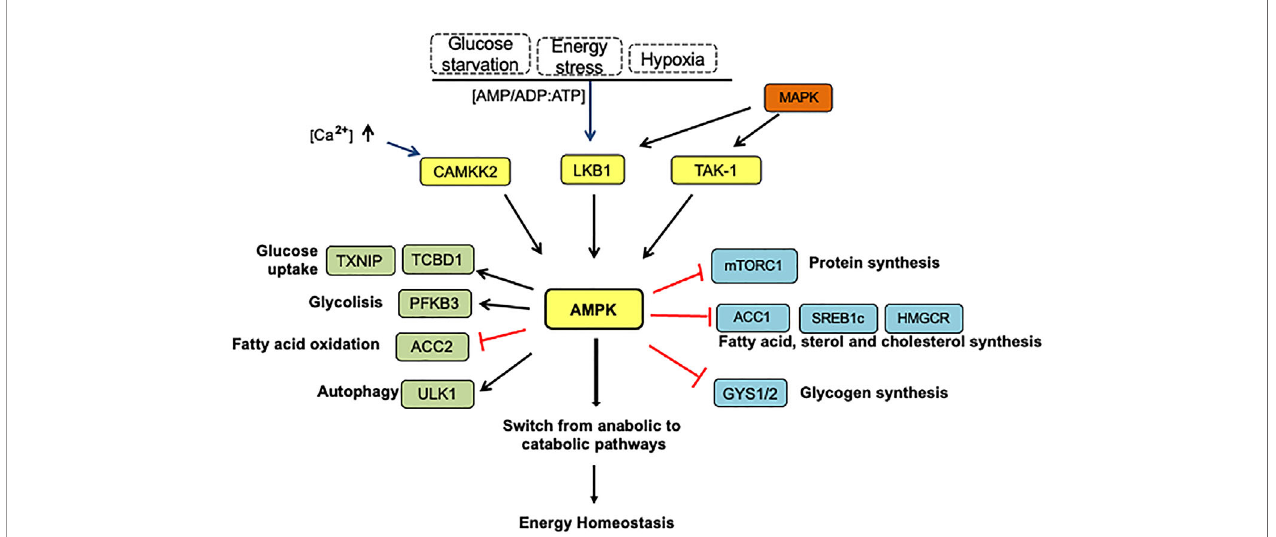
FIGURE 4 | The AMPK pathway activation and energy homeostasis. Under energy stress, AMPK is phosphorylated at Thr 172 by LKB1 in response to variations in AMP: ADP/ATP ratios. Other upstream kinases such as calmodulin-dependent protein kinase kinase 2 (CAMKK2) activated by intracellular calcium and transforming growth factor- b -activated kinase (TAK1) represent alternative AMPK activation forms. In this context, AMPK-activated can repress anabolic processes and increase catabolism to restore energy balance. AMPK suppresses the ATP-consuming anabolic pathways by direct phosphorylation and inhibition of several proteins: mTORC1, acetyl-CoA carboxylase (ACC1), SREBP (sterol response coactivator), HMGCoA reductase (HMGCR), which play critical roles in protein, fatty acid, sterol, and cholesterol synthesis, respectively. AMPK prevents glycogen storage by inhibitory phosphorylation of the glycogen synthases (GYS1 and GYS2). In addition, AMPK also stimulates the catabolic pathways to produce ATP by several mechanisms. First, increasing glucose utilization by phosphorylation and inactivation of domain family member 1 (TBC1D1) and thioredoxin-interacting protein (TXNIP), which control the translocation of glucose transporters GLUT4 and GLUT1 to the plasmatic membrane, respectively. Second, AMPK increases glucose fl ux along the glycolytic pathway by PFKFB3 (6-phosphofructo-2-kinase/fructose-2,6- biphosphatase 3) phosphorylation, which affects the PFK1 activity, a rate-limiting enzyme in glycolysis. AMPK indirectly stimulates fatty acids transport into the mitochondria by ACC2 inhibition, in turn promoting fatty oxidation. On the other hand, AMPK induces autophagy directly by ULK1 phosphorylation, a kinase essential for autophagy, and indirectly by mTORC1 inactivation. The arrows indicate: ! , activation signals; ┴ , inhibition